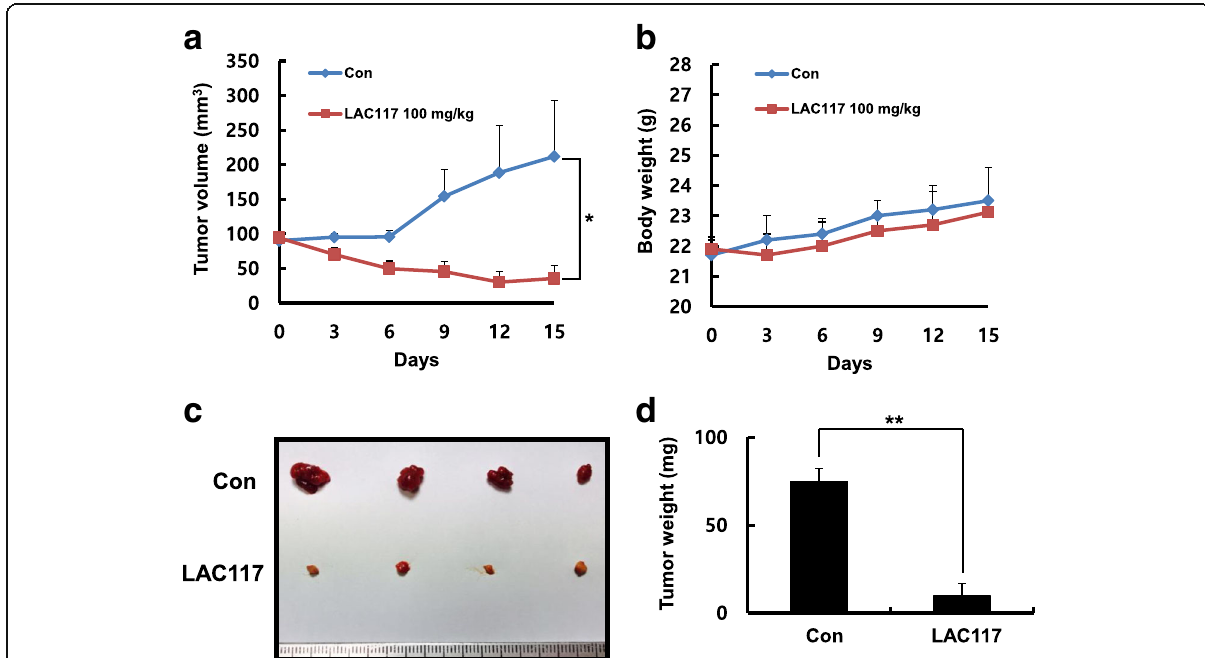
Fig. 6 Tumor growth inhibition of LAC117 in HepG2 HCC xenograft models. a , b After the tumors reached 50 – 100 mm 3 in size, the mice received an intraperitoneal administration of LAC117 (100 μ g/mL) once daily for 15 days ( n = 4, each group). Tumor volume and body weight were measured every 3 days in HepG2 HCC xenograft mouse models. The average tumor volume in the vehicle- or LAC117-treated group was plotted. c , d The tumors were isolated from HepG2 xenograft model, and were weighed immediately. Data are expressed as the mean ± SEM (* P < 0.05 and ** P <